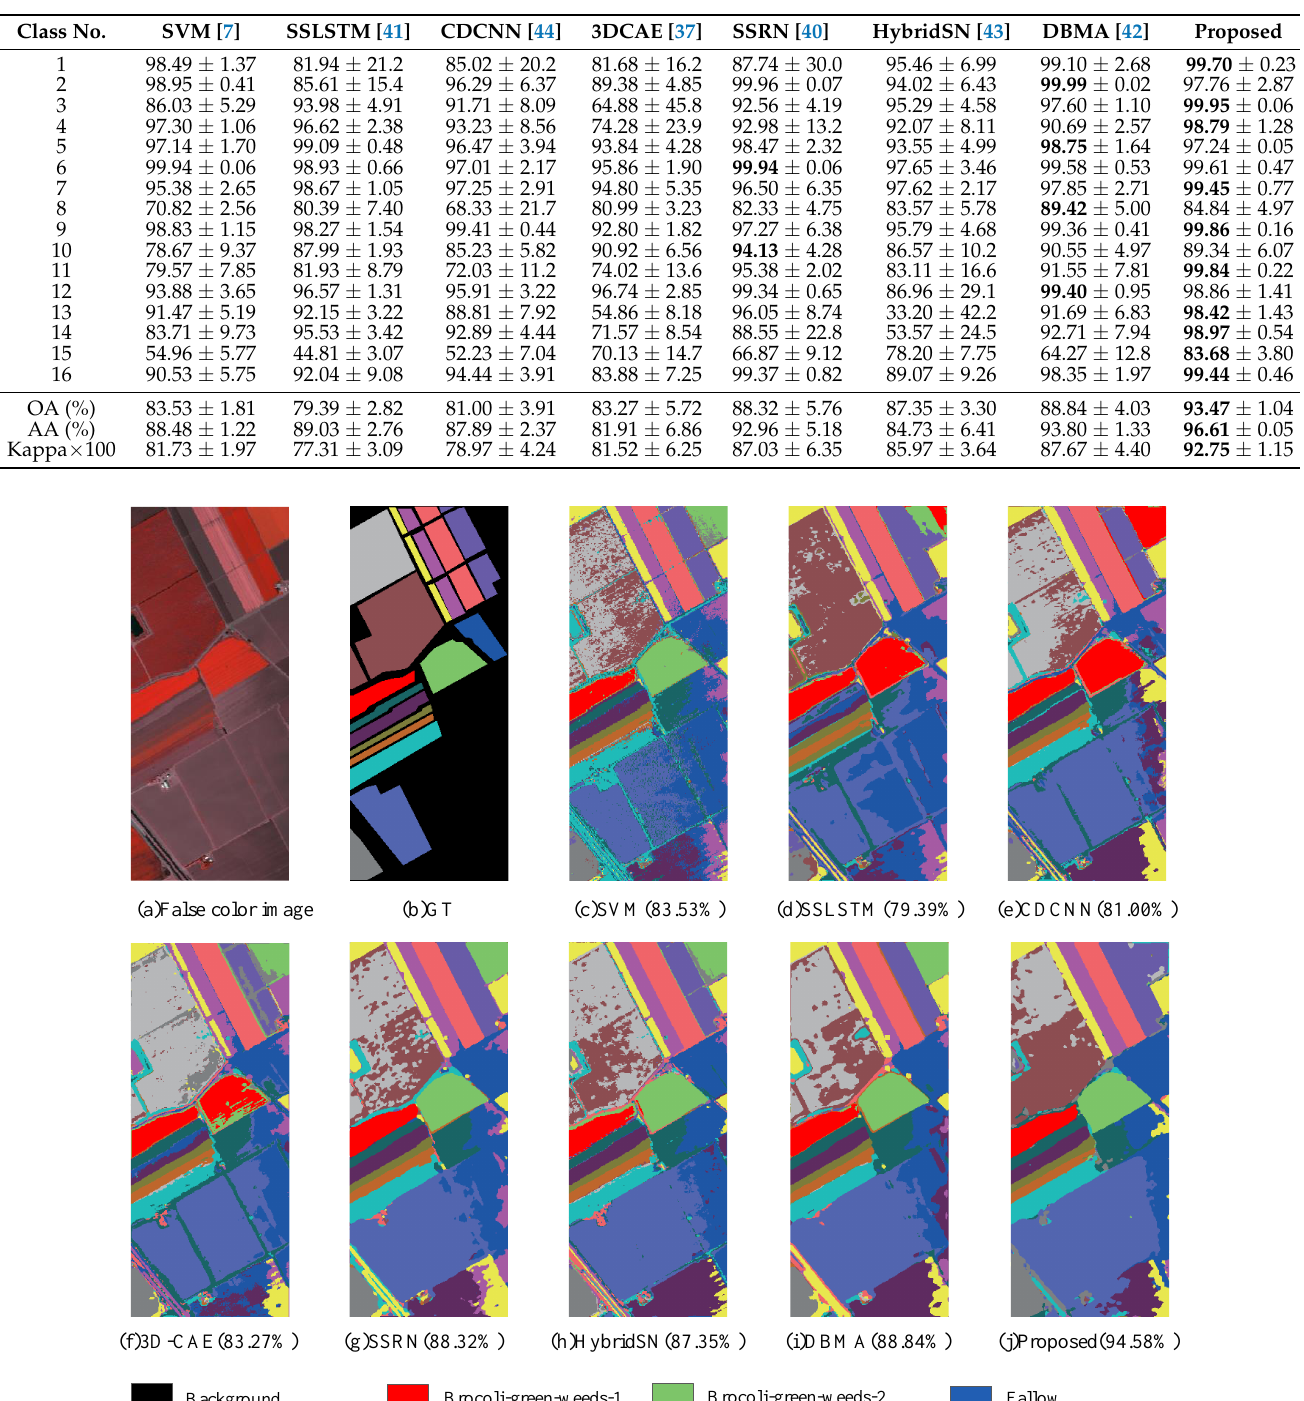
Table 7. Classification results on the Salinas dataset with 10 labeled samples, including OA (%), AA (%) and Kappa × 100 in which the best results are denoted in bold.